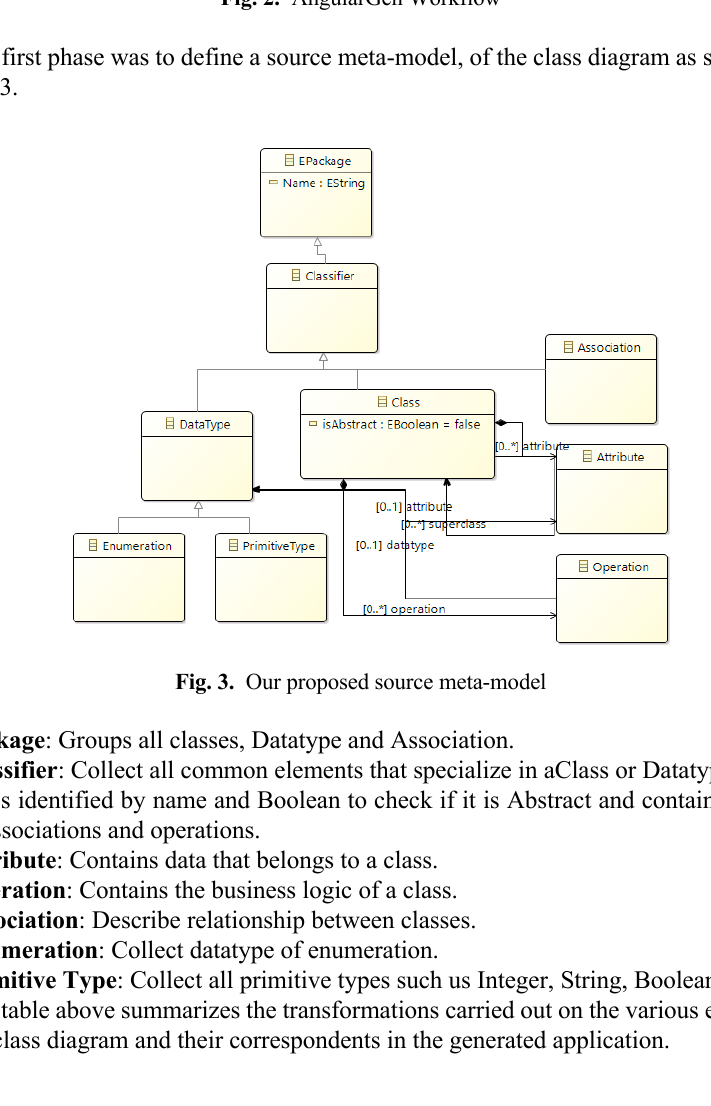
Fig. 2. AngularGen Workflow